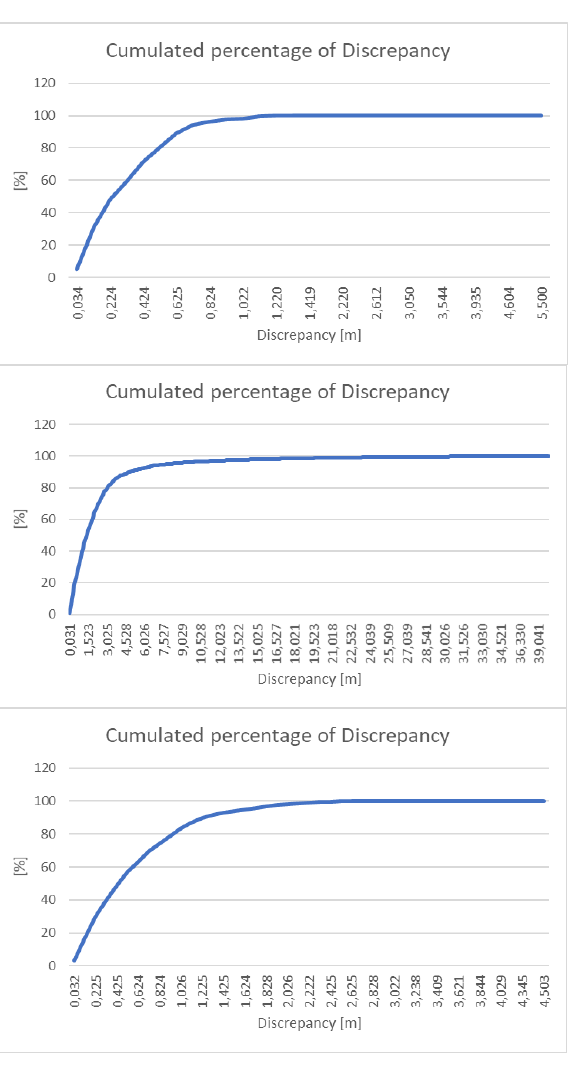
Figure 6. Comparison between the “extracted” and “reference” centrelines obtained from OpenStreetMap (OSM) for the “Vaihingen” (on the left), “Toronto” (on the centre) and “Tobermory” (on the right) Data sets, respectively. Roads are colorized according to discrepancy with respect to the “reference” data.